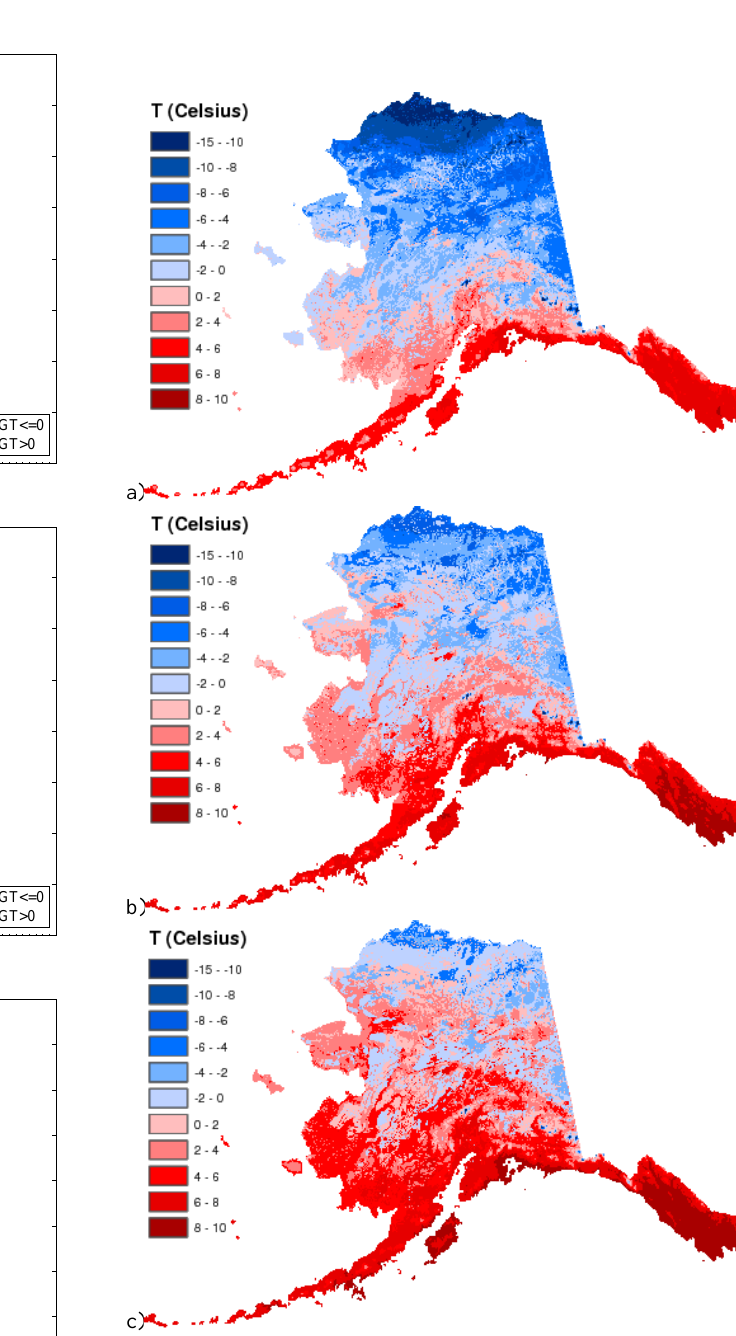
Fig. 12. Projected mean annual ground temperatures (MAGT) for the entire State of Alaska at 2m depth, using downscaled to 2 by 2km climate forcing from GCM composite output with A1B emis- sion scenario for the 21st century for years (a) 2000, (b) 2050 and (c)